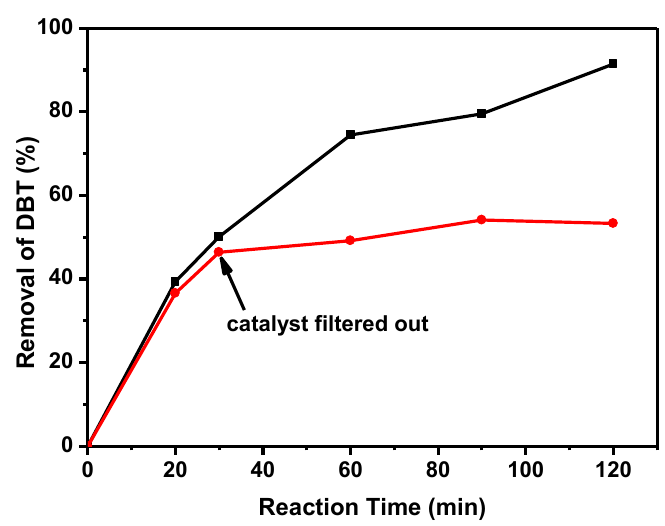
Figure 6. Reaction temperature effect on catalytic reactivity of 50%Ti-MIL-101-550.